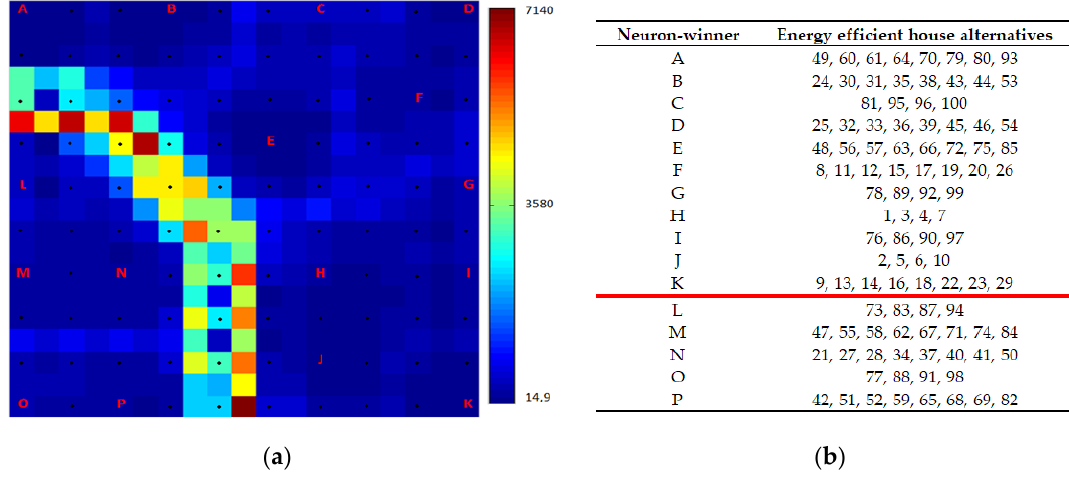
Figure 10. Visualization of combinations: ( a ) Combinations of alternative energy-efficient solutions on the SOM; ( b ) Neurons-winners for alternative combinations.